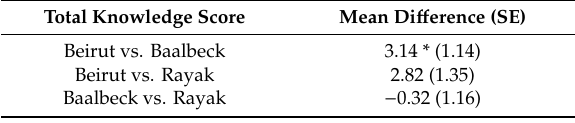
Table A7. Total knowledge score di ff erences between the three locations (Beirut, Baalbeck and Rayak).